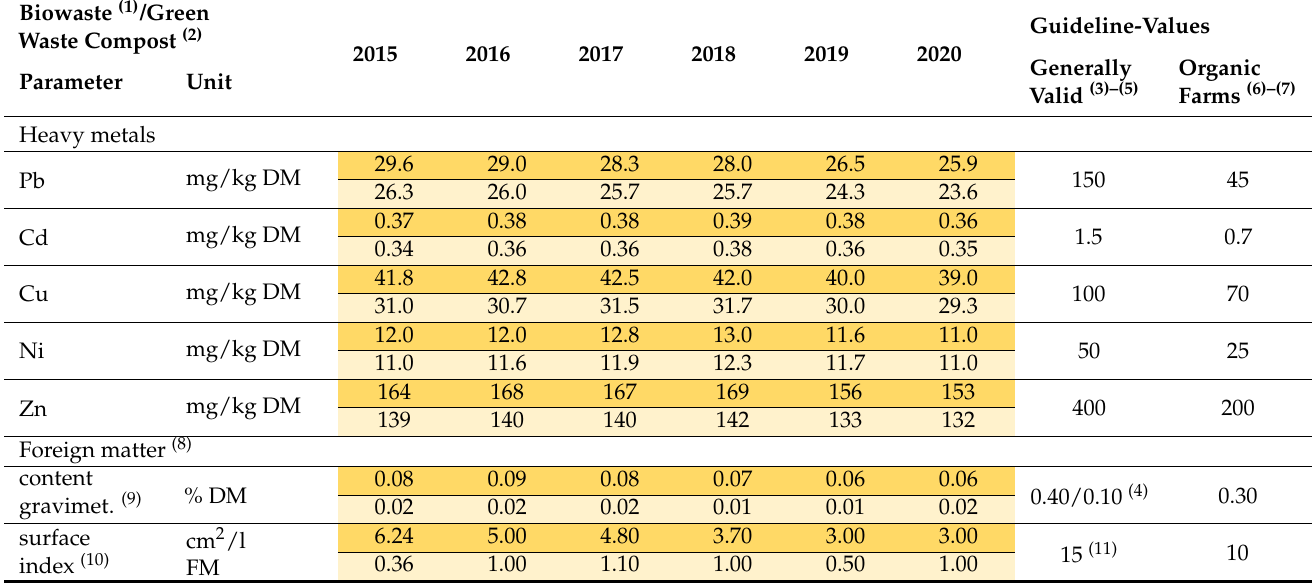
Table 2. Average foreign matter and heavy metal content of quality-assured composts compared to the requirements of organic farming in Germany in 2015–2020 (composts according to RAL-GZ 251 Compost from BGK).